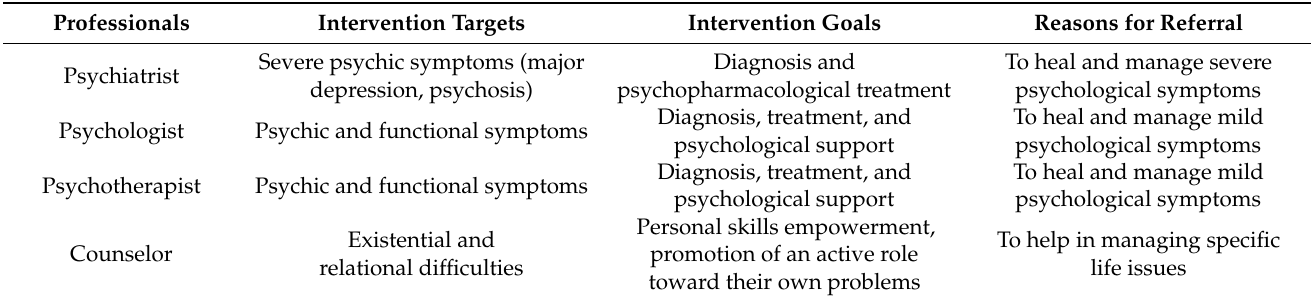
Table 2. The prevalent GPs’ beliefs about mental health